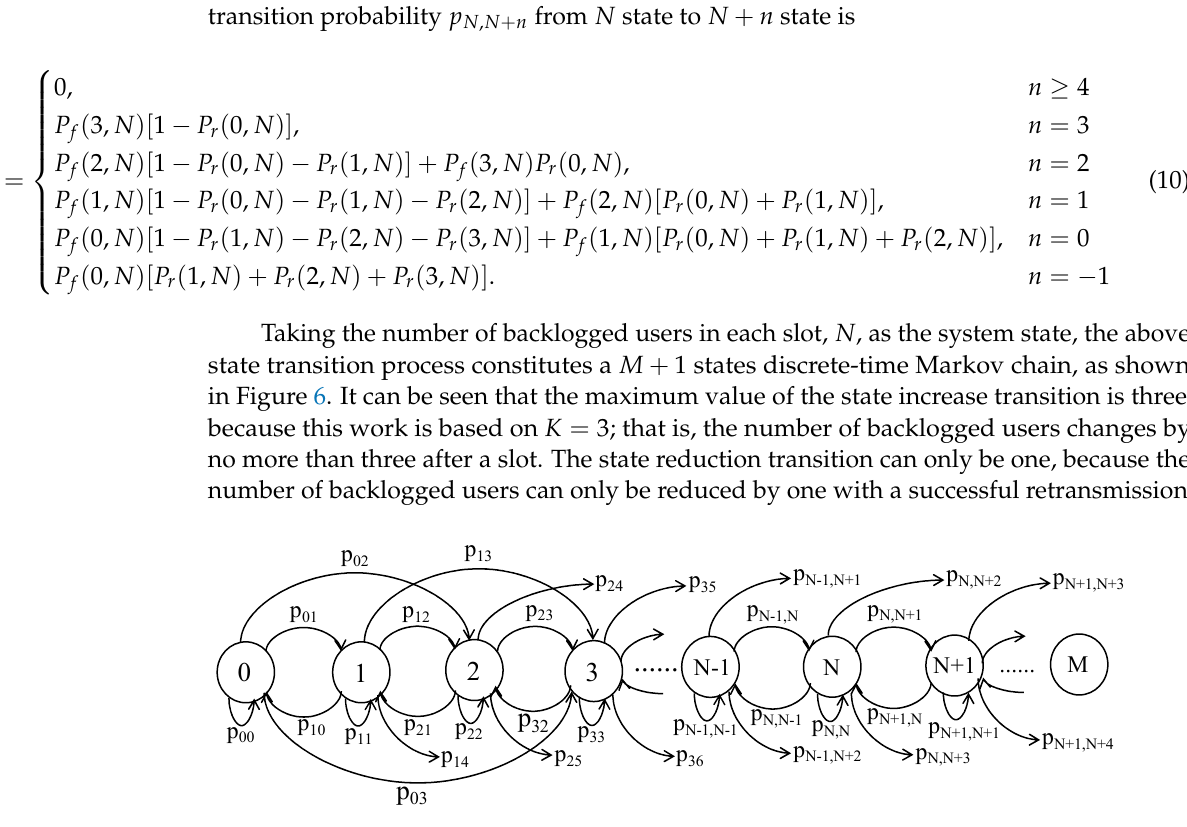
Figure 6. State transition diagram of a novel frameless slotted ‐ ALOHA system.